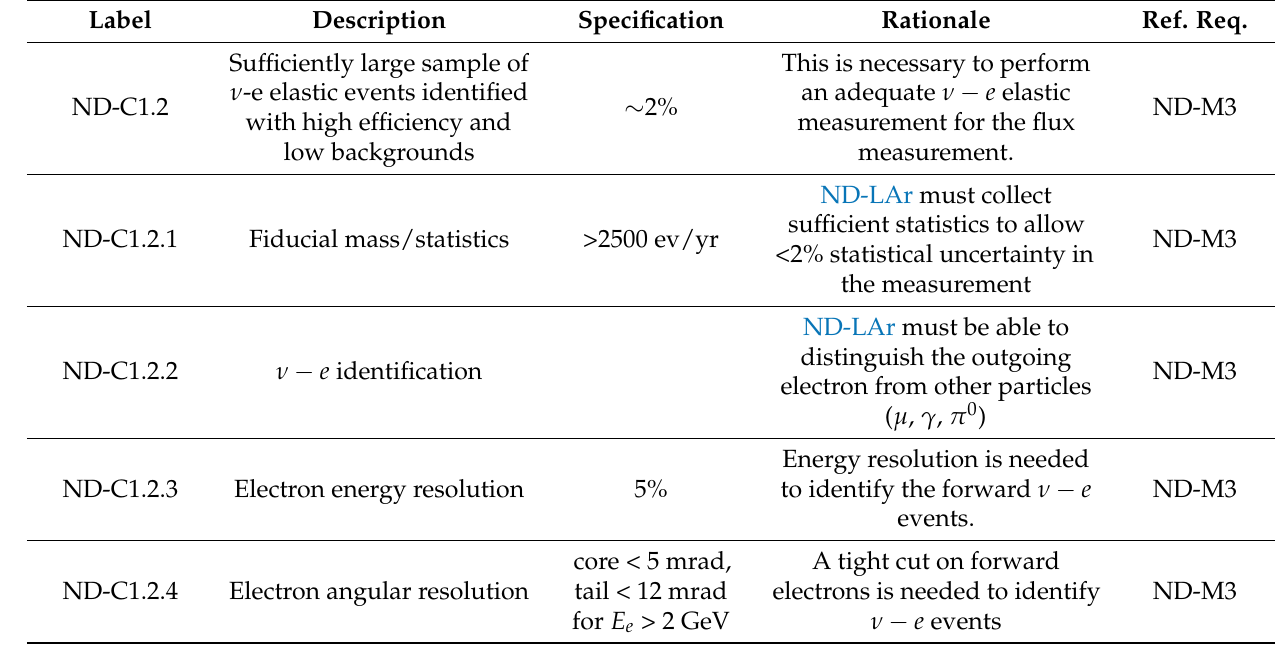
Table 5. ND-M3 capability requirements for